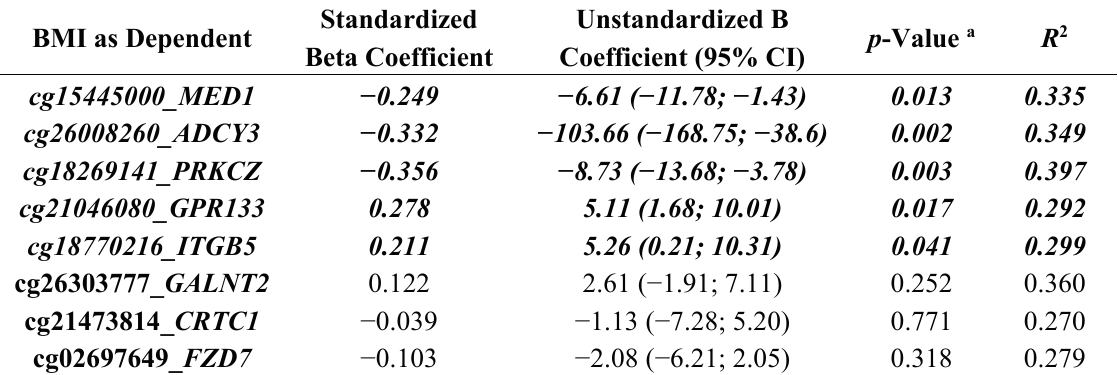
Figure 3. Associations between CpG sites that exhibit differential DNA methylation between the HRO groups and the expression levels of their respective genes in WBC from the RESMENA cohort. Data are presented as linear regression (solid straight line) graph and 95% confidence interval (dotted lines). ( a ) cg21046080 and GPR133 ; ( b ) cg18770216 and ITGB5 . Table 2. Lineal regression analyses showing the contribution of DNA methylation to the variation of BMI adjusted by age, gender, smoking, metabolic syndrome, the research group that made each study, and batch effect in the pooled population ( n =